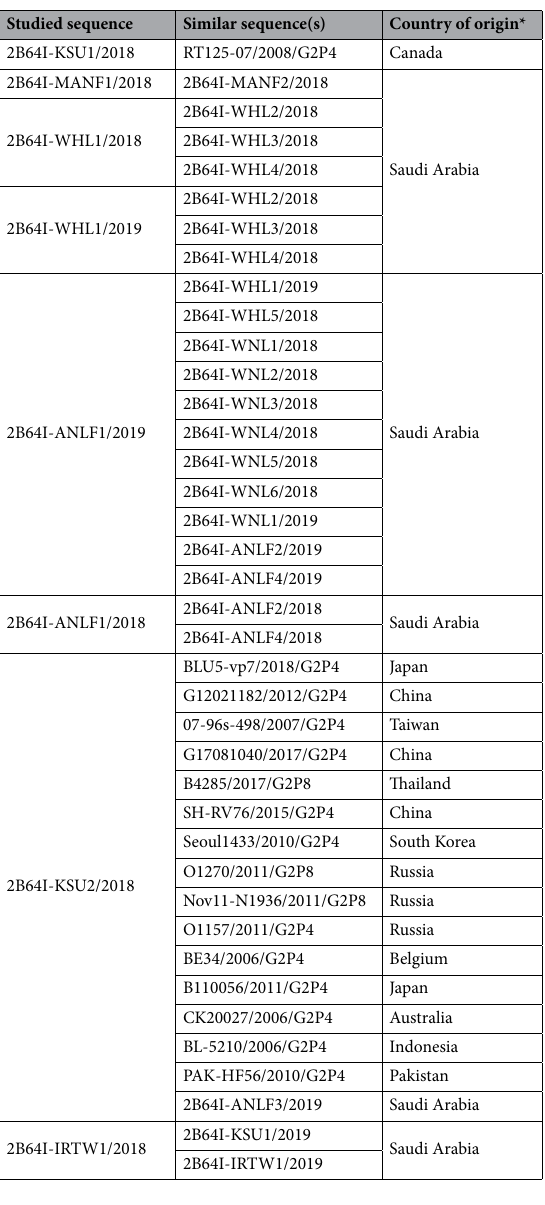
Table 2. HRVA sequences grouping (Grouping is based on zero-distance between studied sequences as well as extraneously with other strains used for phylogenetic analysis implemented by pairwise distancing using Kimura three-parameter method). *Country of origin of similar sequences.